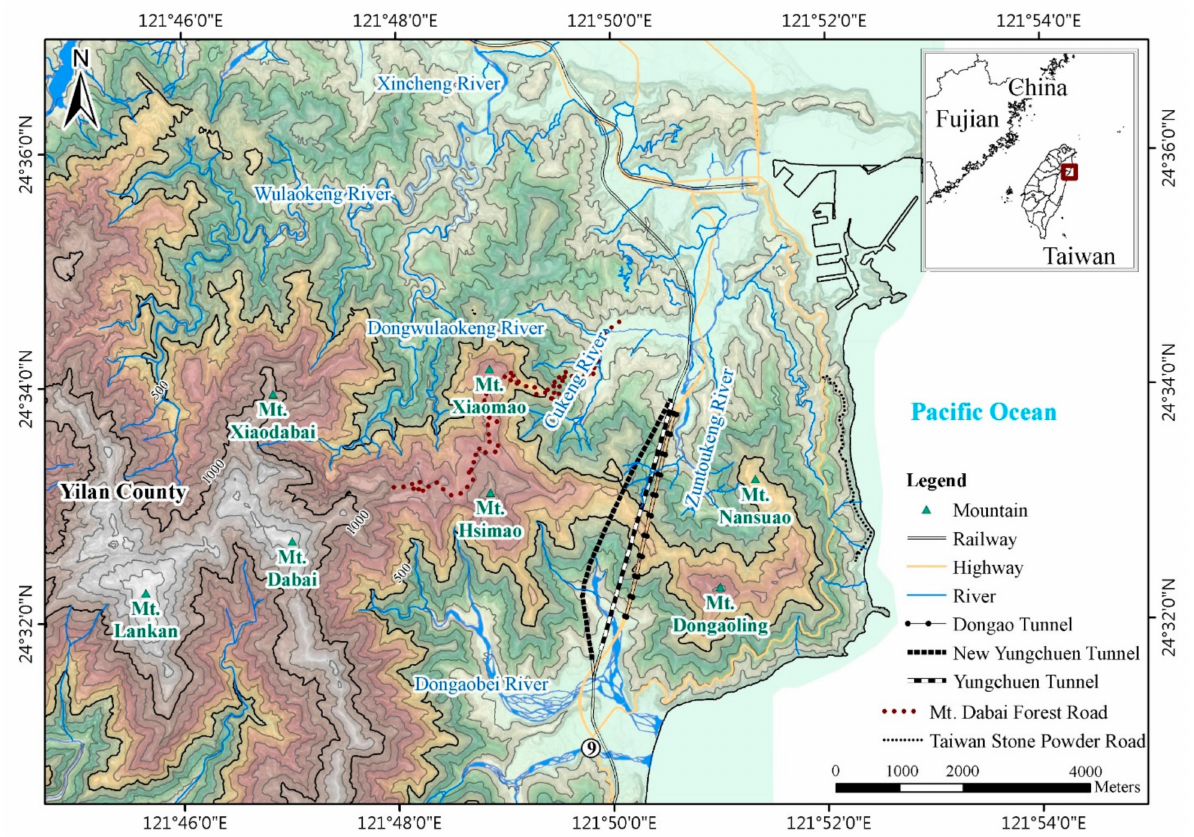
Figure 1. Topographic map of the study